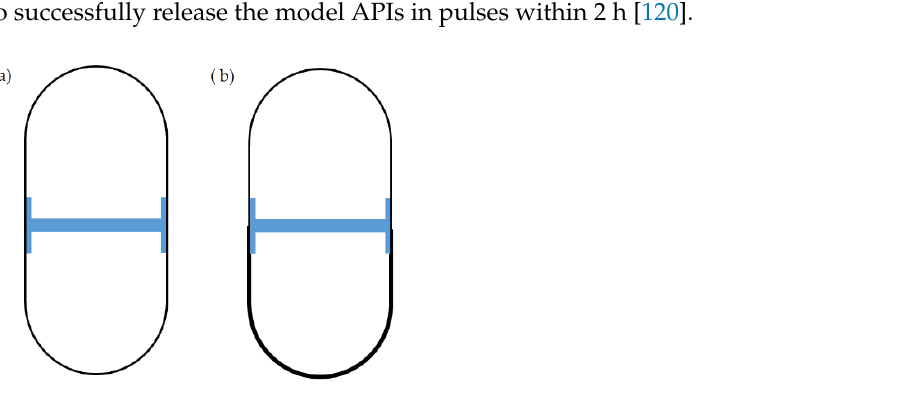
Table 3. The grouping of the manufactured capsules based on the publication year and then in al- phabetical order. Year